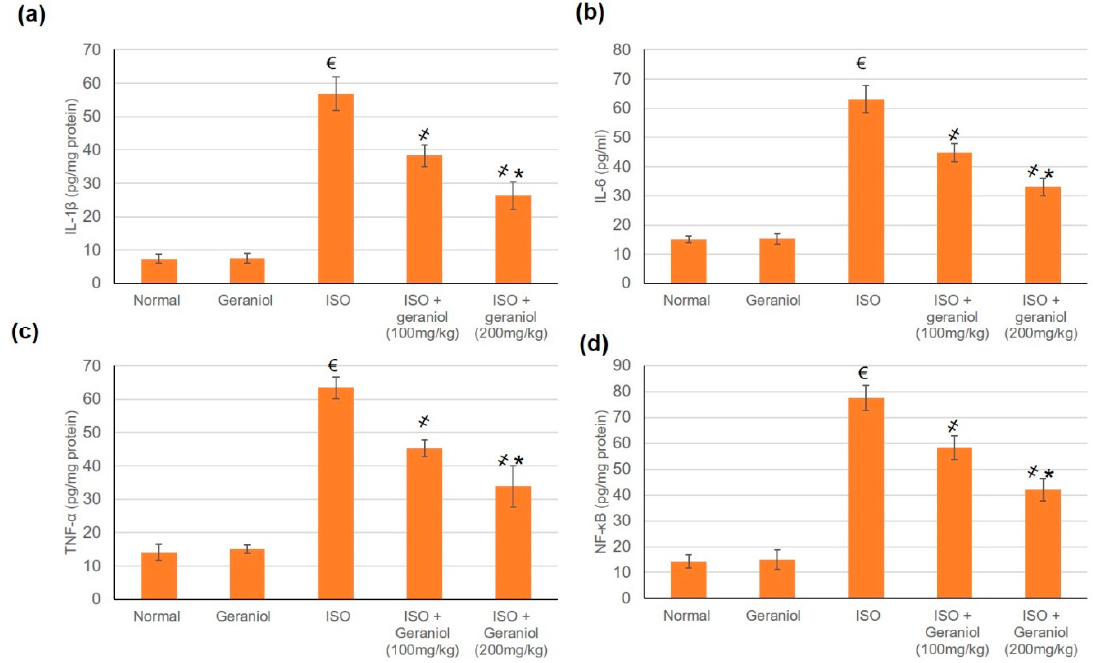
Figure 6. Pretreatment with geraniol (100 or 200 mg / kg) partially suppressed the increase in the levels of inflammatory markers ( a ) IL-1 β , ( b ) IL-6, ( c ) TNF- α , and ( d ) NF- κ B in response to ISO-induced MI in rats. ISO: isoproterenol. All values were stated as mean ± SD ( n = 6). € , p < 0.05 compared to the normal group;